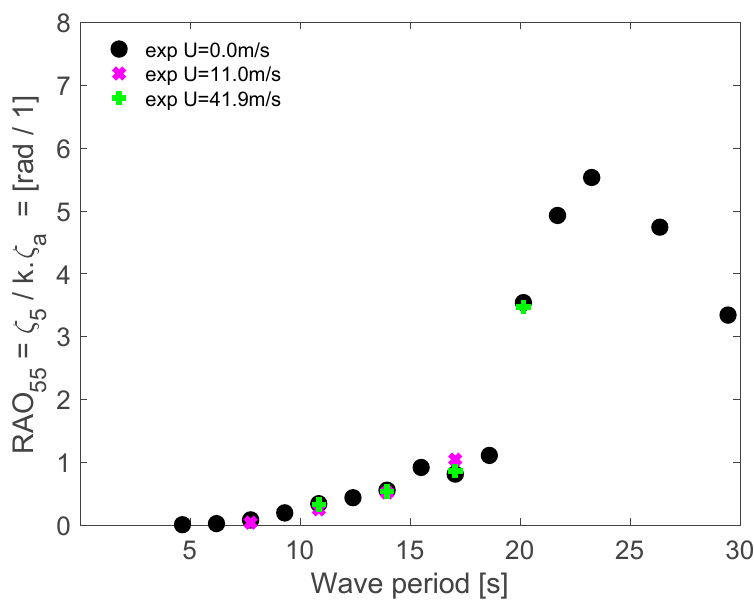
Figure 16. E ff ect of the incident wind speed on the experimental RAO pitch motion results. Figure 16. Effect of the incident wind speed on the experimental RAO pitch motion results.